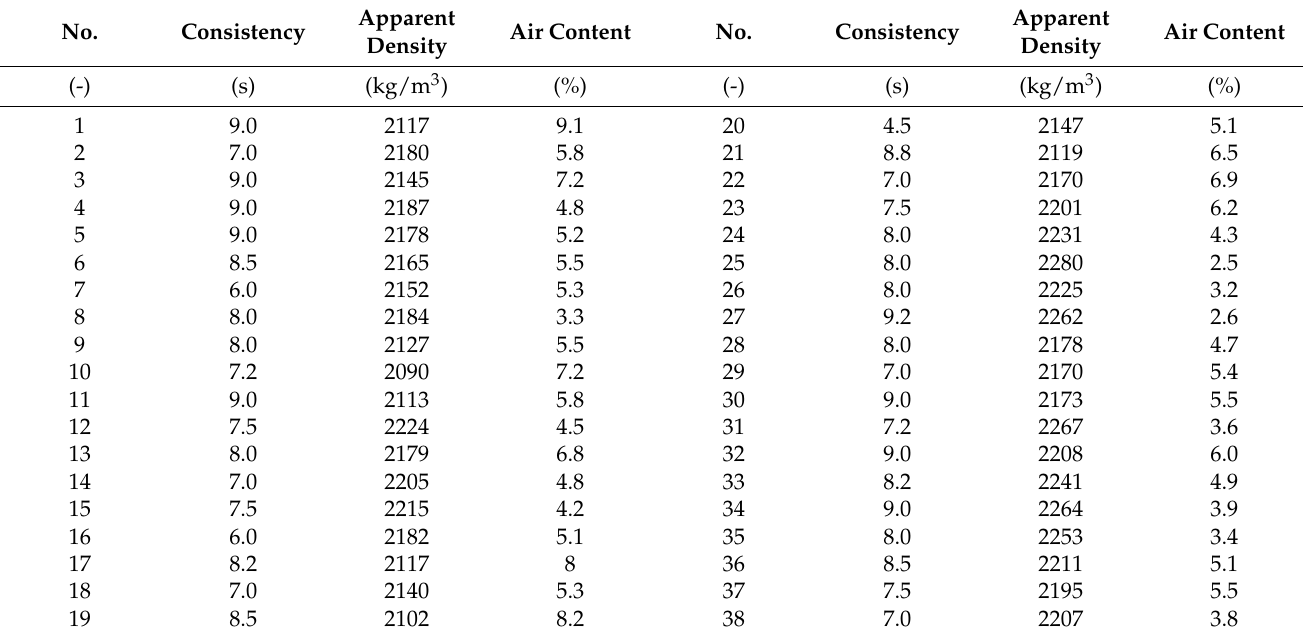
Table 3. Fresh concrete mix properties—stage I of the tests.